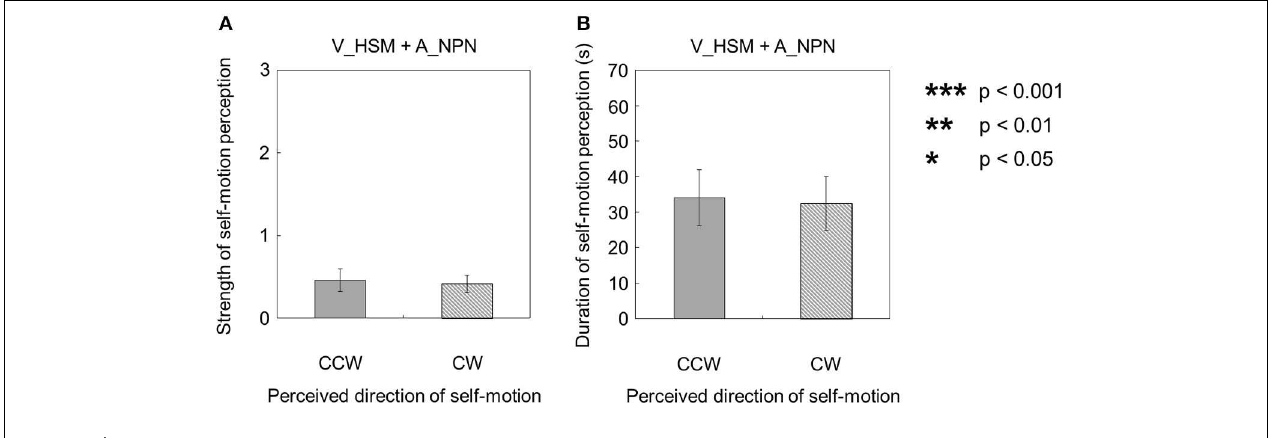
one-directional motion (A_HOM). The values are plotted by clockwise (CW) and counterclockwise (CCW) directions. The error bars represent standard error (SE).